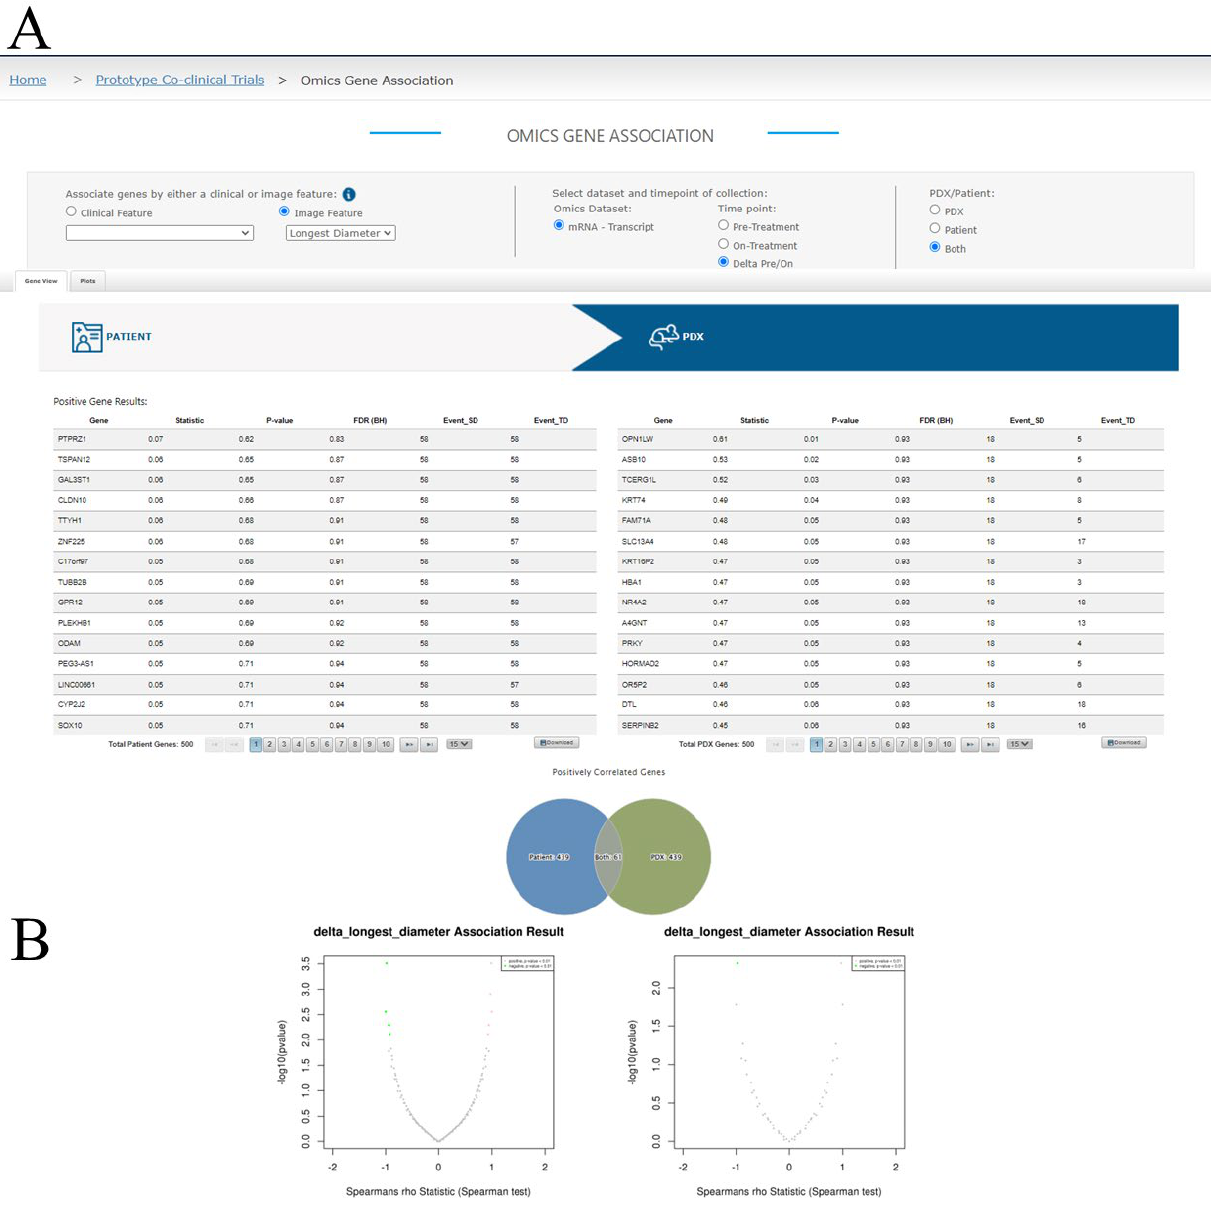
Figure 6. MIRACCL’s omics module. ( A ) The feature and dataset selector accepts user inputs which are passed to LinkedOmics via API for analysis. ( A ) Search results containing the top 500 and bottom 500 genes for patient and PDX are returned to MIRACCL and displayed in side-by-side tables. Venn diagrams visualizing the count of distinctive and overlapping genes between the patient and PDX cohorts are shown. ( B ) Volcano plots found on the Plots tab visually represent association results of Spearman tests for both patient and PDX cohorts.